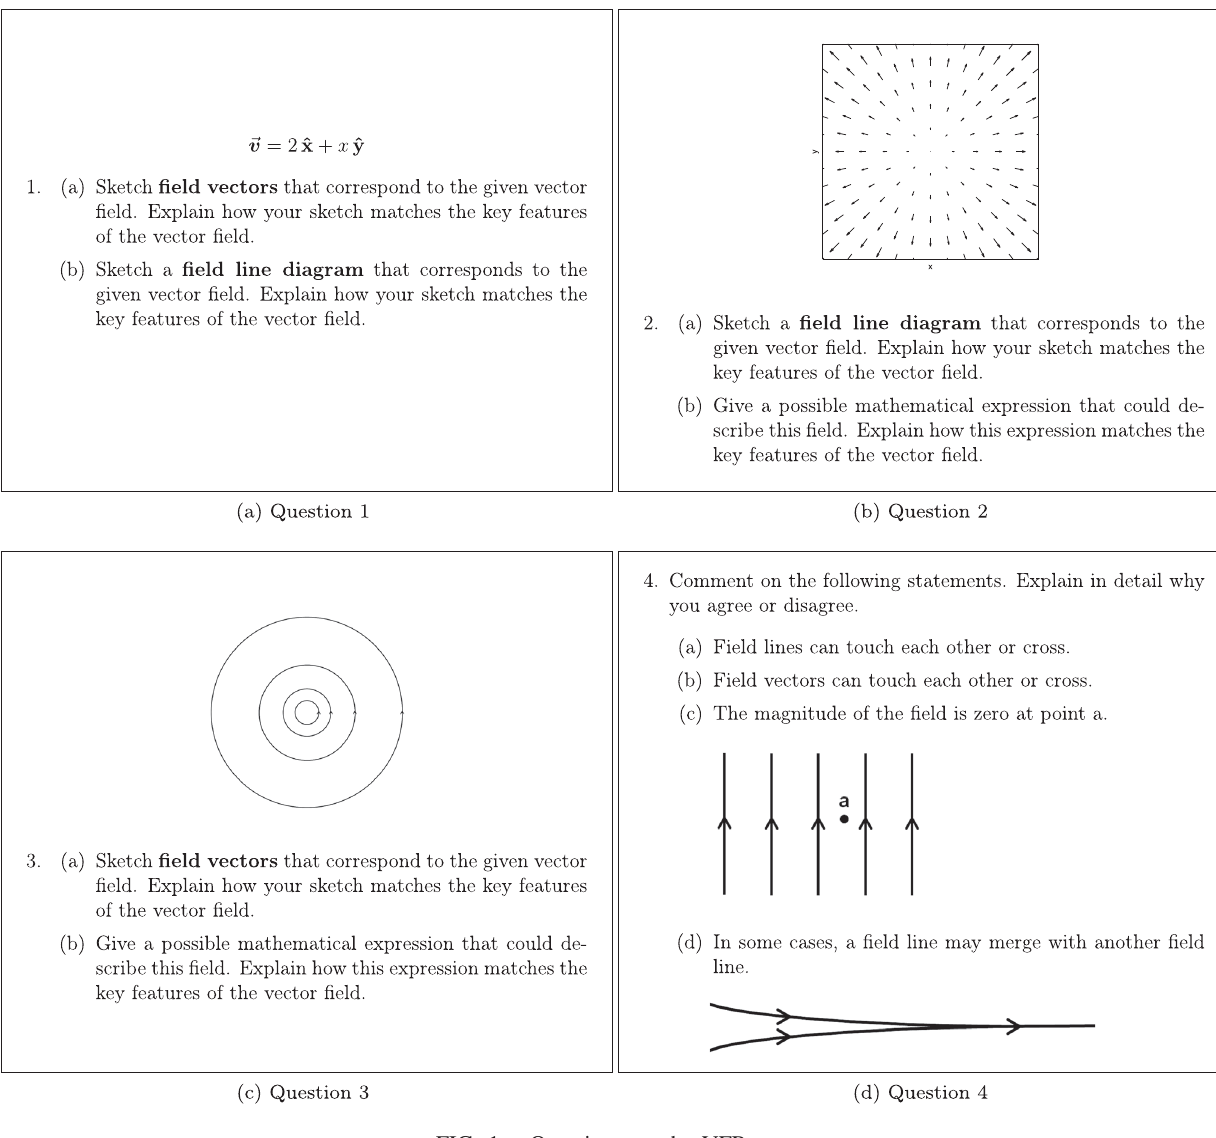
FIG. 1. Questions on the VFR